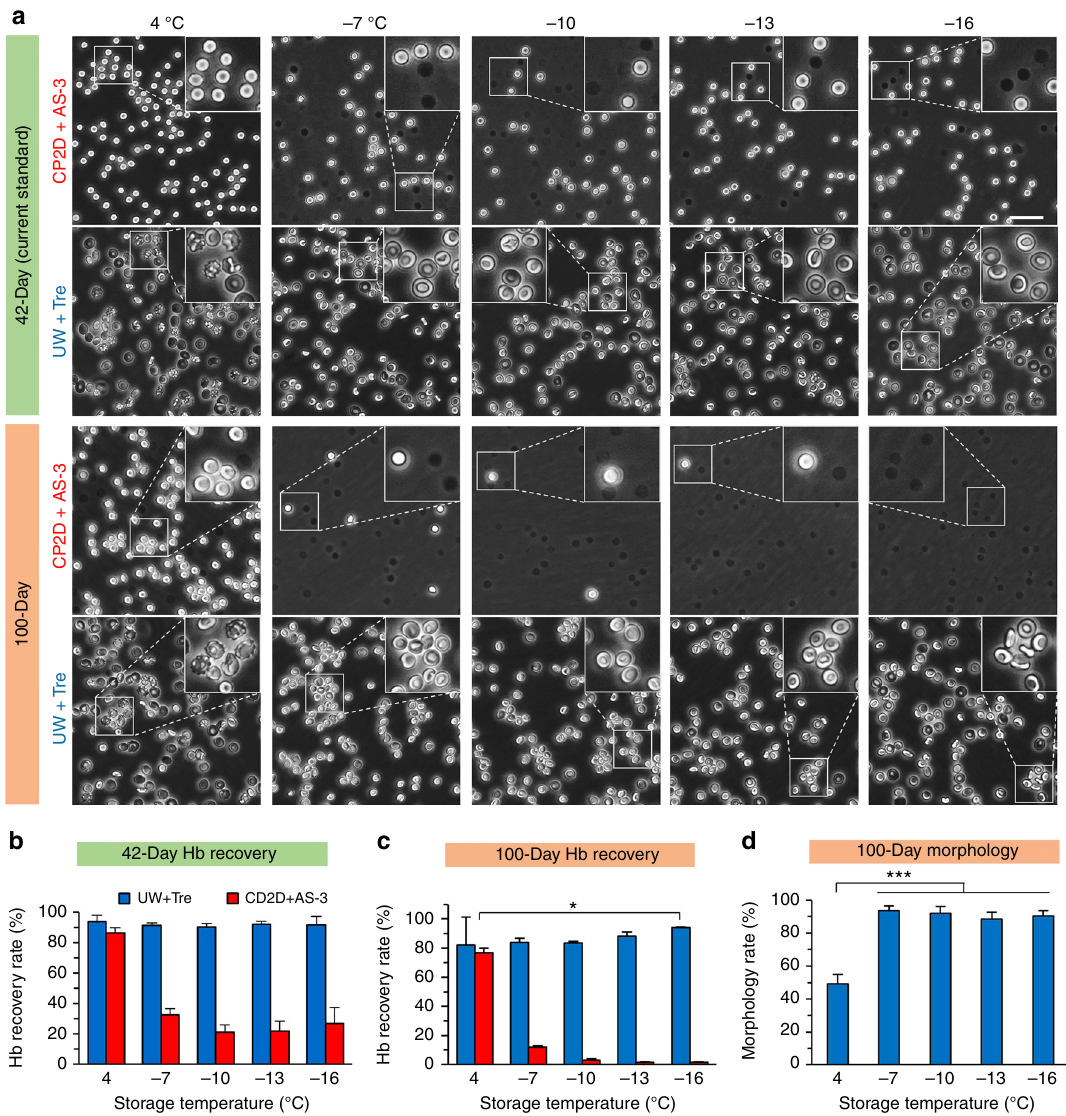
Fig. 5 Cold storage and deep-supercooled preservation of human red blood cells. a Preservation of human red blood cells (hRBCs) for 42 and 100 days at various temperatures in conventional anticoagulant citrate phosphate double dextrose (CP2D) supplemented with additive solution 3 (AS-3) (CP2D + AS-3), and UW solution supplemented with 5% (w/v) trehalose (UW + Tre). Black dots are the debris of lysed RBCs without holding hemoglobin. Successful DSC for 1 ml suspension of 10 million hRBCs in polystyrene tubes was achieved by surface sealing with 0.5 ml PO. Scale bar is 50 µ m. b Hemoglobin recovery rate of RBCs post 42-day storage. n = 3. c Hemoglobin recovery rate of RBCs post 100-day storage. n = 3. d The percentages of RBCs with normal morphology and size post 100-day storage in UW + Tre solution. Bright disk-shaped RBCs with smooth plasma membrane and diameter 5 µ m ≤ D ≤ 10 µ m are regarded as normal morphology. n = 3. The total number of counted cells N = 1800 ± 50 for each case. Error bars represent standard